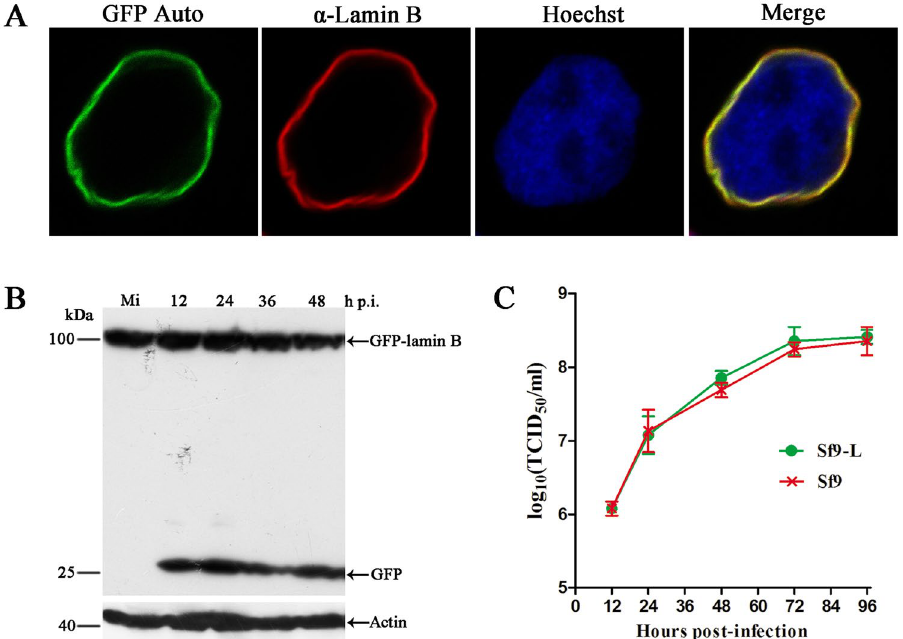
Figure 1. Generation of the Sf9-L clonal cell line. ( A ) Subcellular localization of lamin B in Sf9-L cells. The cells were fixed, permeabilized, stained with the mouse monoclonal antibody ADL67, and visualized with donkey anti-mouse IgG conjugated to Alexa Fluor 555 (red) as the secondary antibody to detect both native lamin B and chimeric GFP-lamin B. Chimeric GFP-lamin B was detected by visualizing GFP autofluorescence (GFP- Auto, green). Hoechst 33342 was used to identify the nuclei and DNA-rich regions (blue). ( B ) Time course analysis of total GFP-lamin B. Sf9-L cells were mock-infected or infected with vAcWT at an MOI of 10. At the indicated time points, the cells were collected, resolved by SDS-10% PAGE, and subjected to Western blotting with a mouse monoclonal antibody against GFP and an anti-actin antibody as a loading control. Mi, mock- infected Sf9-L cells. ( C ) Viral replication analysis in Sf9-L and Sf9 cells. Sf9-L and Sf9 cells were infected with vAcWT-mCh at an MOI of 5, and the supernatants were harvested at the selected time points. The titers were determined using TCID 50 assays. Each data point represents the average of three independent infections. The error bars represent the standard deviations.